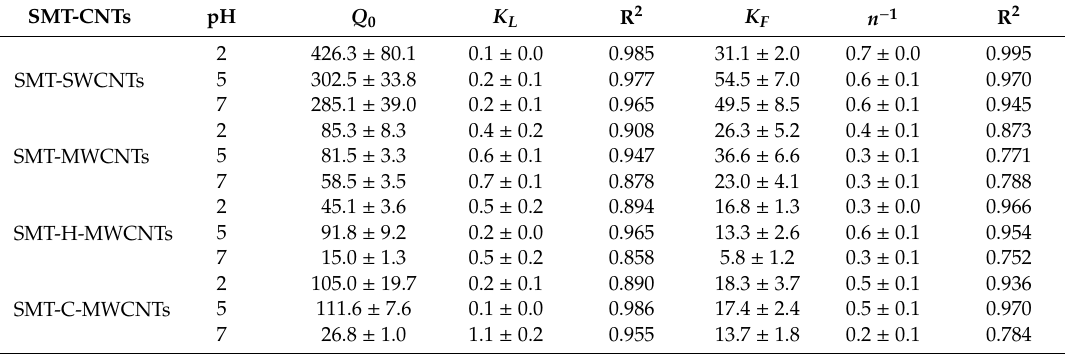
Table 1. Adsorption isotherm parameters ( ± standard error of mean (SEM)) obtained from experimental data fitted with Langmuir and Freundlich models (Equations (1) and (2)) for the adsorption of sulfamethazine (SMT) onto single-walled CNTs (SWCNTs), multi-walled CNTs (MWCNTs), hydroxylated multi-walled CNTs (H-MWCNTs), and carboxylated multi-walled CNTs (C-MWCNTs) in the aqueous solution at pH 2, 5, and